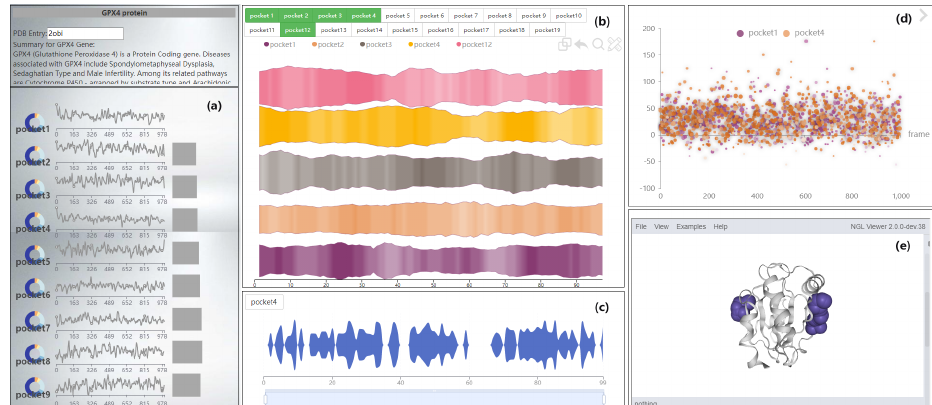
Figure 1. VAPPD representation for the abstracted overview of protein pocket exploration over time. The navigation view ( a ) shows the volume change trend of all cavities in the protein (line chart), the hydrophilic and hydrophobic properties of pockets (pie chart), and the correlation between pockets (bar chart). The pocket comparison view ( b ) is used to select some pockets for pocket feature comparison. The pocket properties of comparison include pocket stability (river opacity) and pocket volume (river width). The magnifying glass view ( c ) shows the pocket features after partial magnification. Open the “magnifier” component and start the view. Other feature views ( d ) mainly show the changes of hydrophilicity and polarity of the pocket with time, which can be switched to the form of scatter chart or pie chart. In the pie chart form, the pocket-lining amino acids in each timestep can be viewed. The 3D visual view ( e ) describes the morphology, position, and changes of molecules and pockets. This helps users to establish the interaction between two-dimensional and